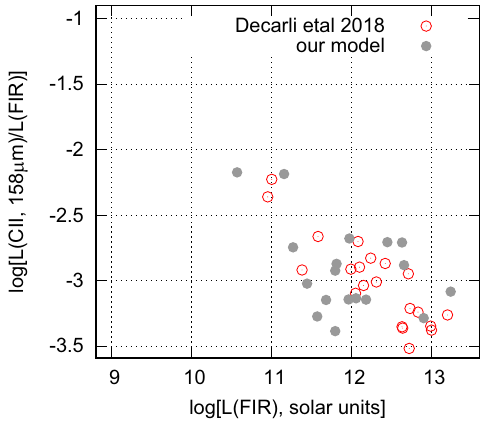
Figure 3: The luminosity ratio of the [ CII ] 158 μm line to the FIR continuum versus the FIR continuum. The fi lled grey circles show the ratio for our models. The open red circles depict the results from Decarli et al . ( 2018 ) , and the data are taken from their Table 5. The FIR continuum is integrated over = λ 42.5–122.5 μm